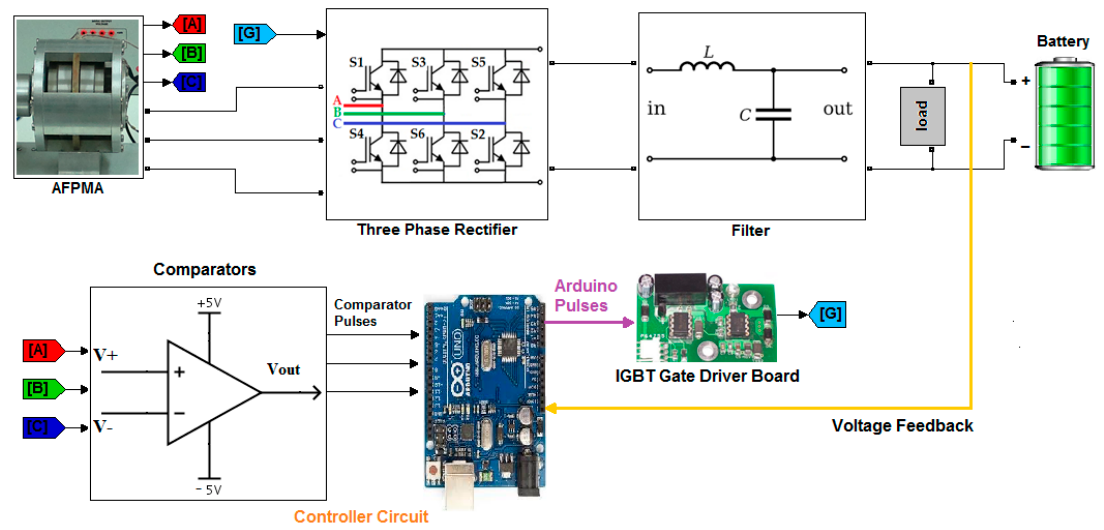
Figure 9. Proposed automotive electrical powering system using AFPMA harnessed with fully controlled AC/DC rectifier.